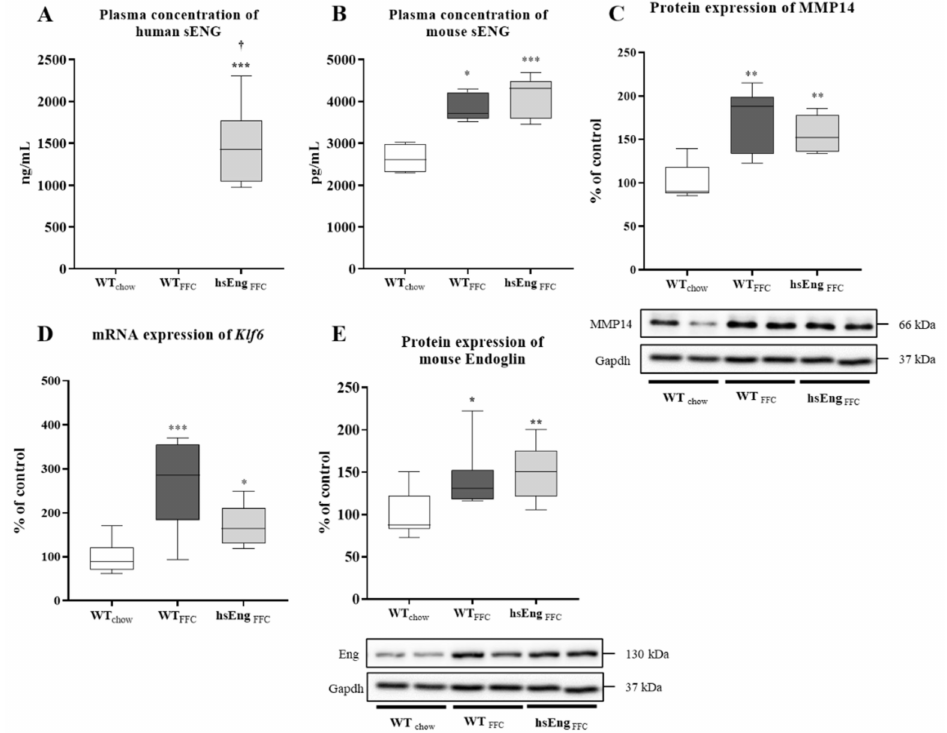
Figure 2. Human and mouse sEng levels in the blood, Eng, Klf6 , and MMP14 expression in liver. Plasma levels of human sEng ( A ). Plasma levels of mouse sEng ( B ). Protein expression of MMP14 ( C ). mRNA expression of transcription factor Klf6 ( D ). Protein expression of mouse Eng ( E ). The data are presented as median with box and whiskers representing the interquartile range and 5th–95th percentiles ( n = 8). * p < 0.05, ** p < 0.01, *** p < 0.001, using the Kruskal–Wallis test; † p < 0.05, using the Mann–Whitney test wild type mice fed with high-saturated fat, high-fructose high-cholesterol diet versus high human soluble endoglin mice fed with high-saturated fat, high-fructose, high-cholesterol diet (WT FFC –hsEng FFC